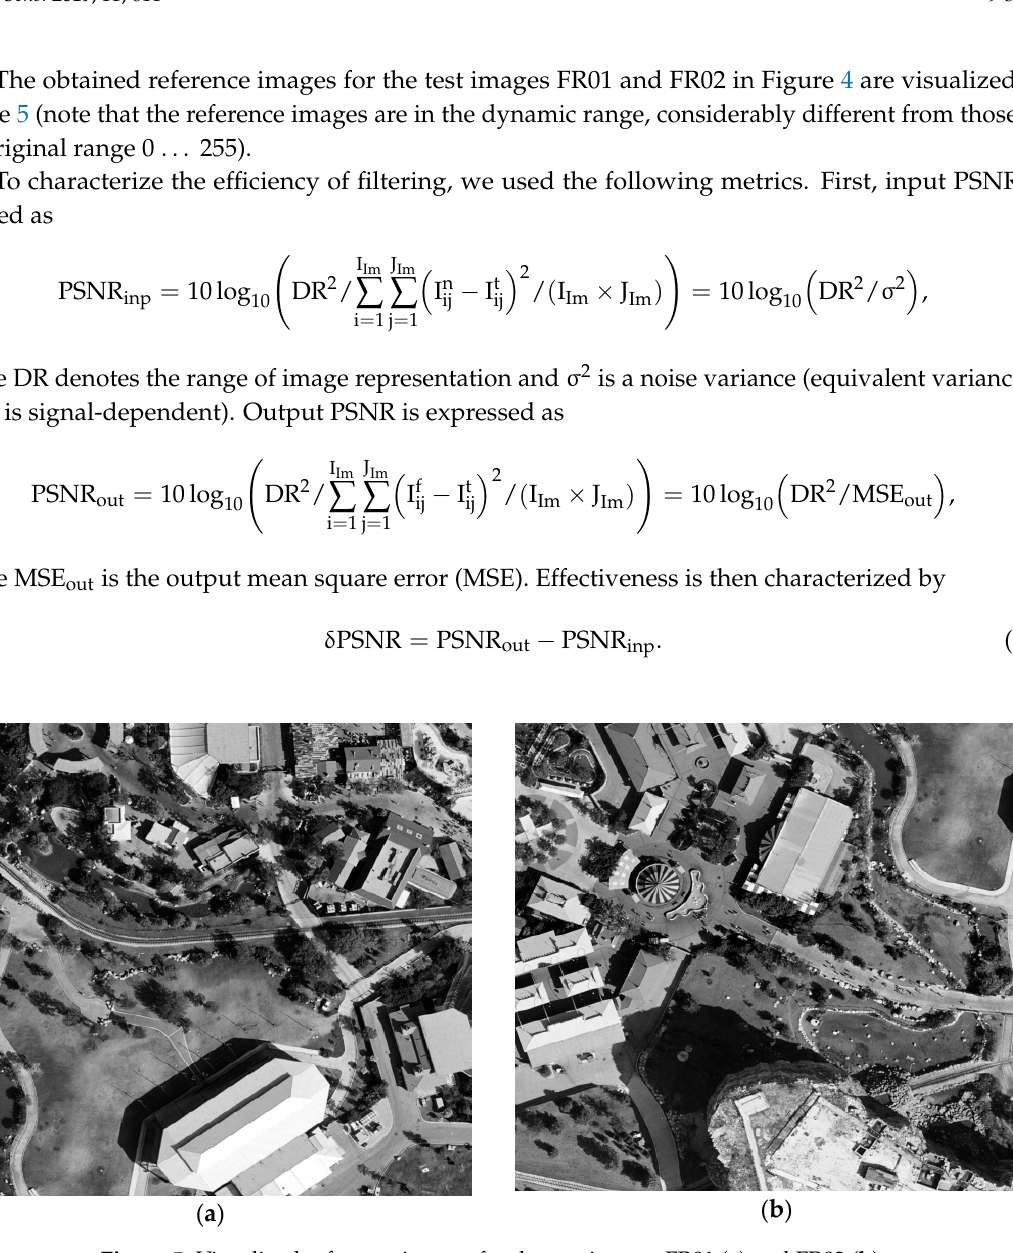
Figure 5. Visualized reference images for the test images FR01 ( a ) and FR02 ( b ).